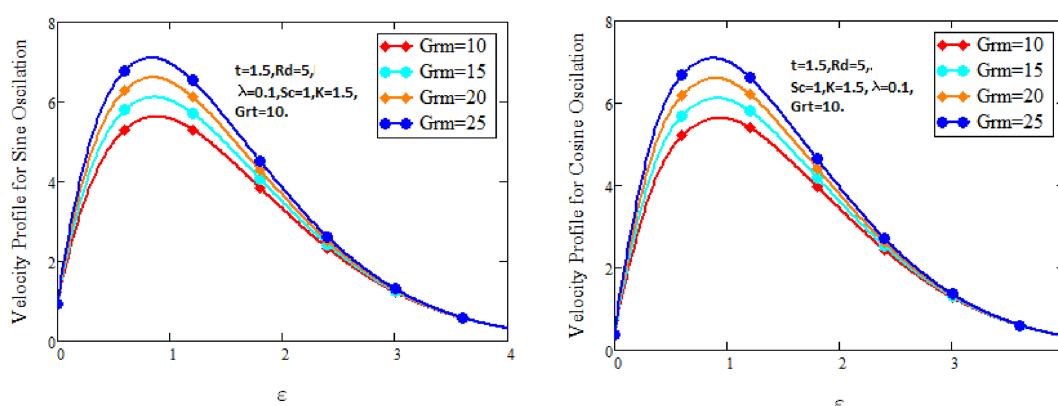
Figure 4. Velocity curves for various values of Gr m .